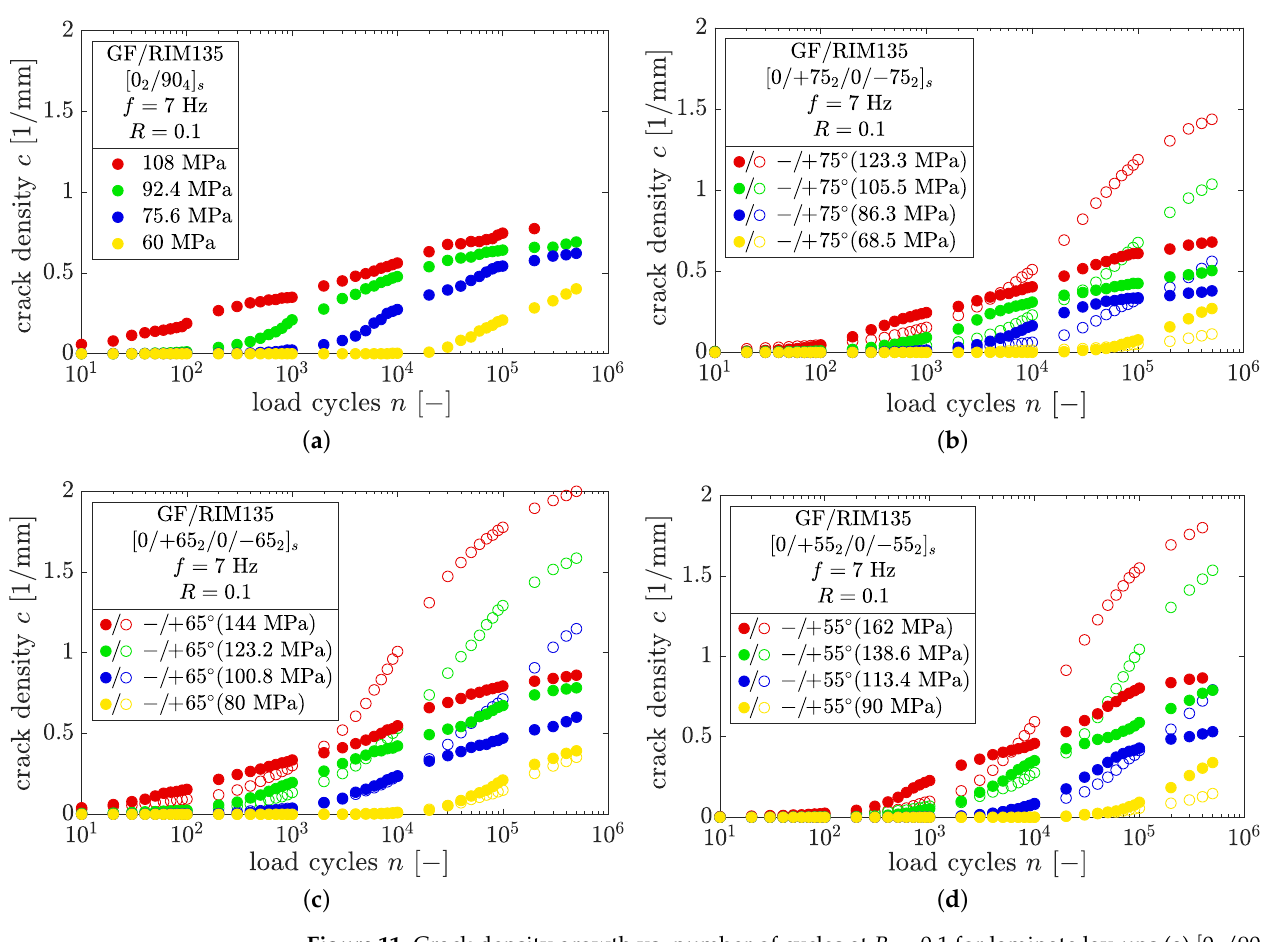
Figure 11. Crack density growth vs. number of cycles at R = 0.1 for laminate lay-ups ( a ) [ 0 2 /90 4 ] s , ( b ) [ 0/ + 75 2 /0/ − 75 2 ] s , ( c ) [ 0/ + 65 2 /0/ − 65 2 ] s and ( d ) [ 0/ + 55 2 /0/ − 55 2 ] s under fatigue